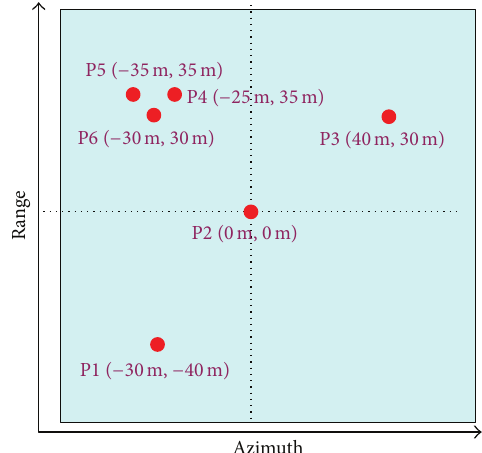
Figure 8: The designed imaged scene in the slant range plane with six point